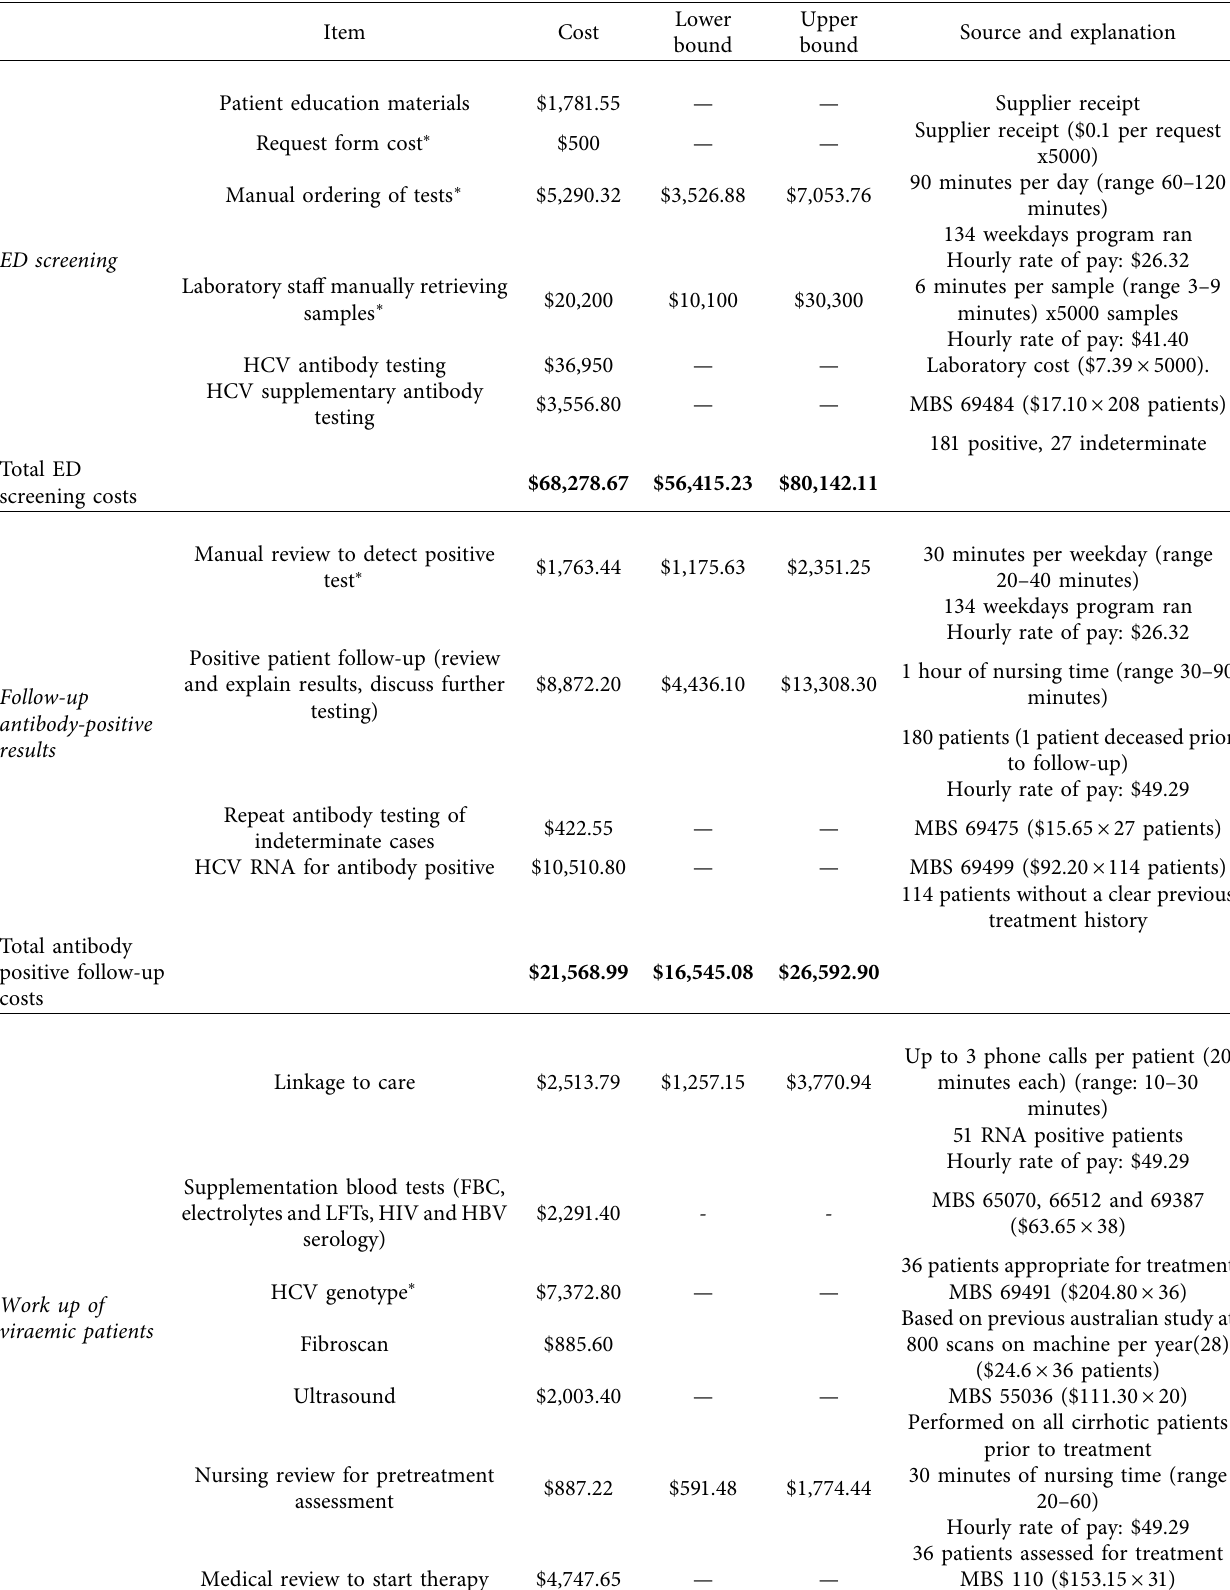
Table 2: Detailed costs of items included in SEARCH 1.0 cost analysis and source of